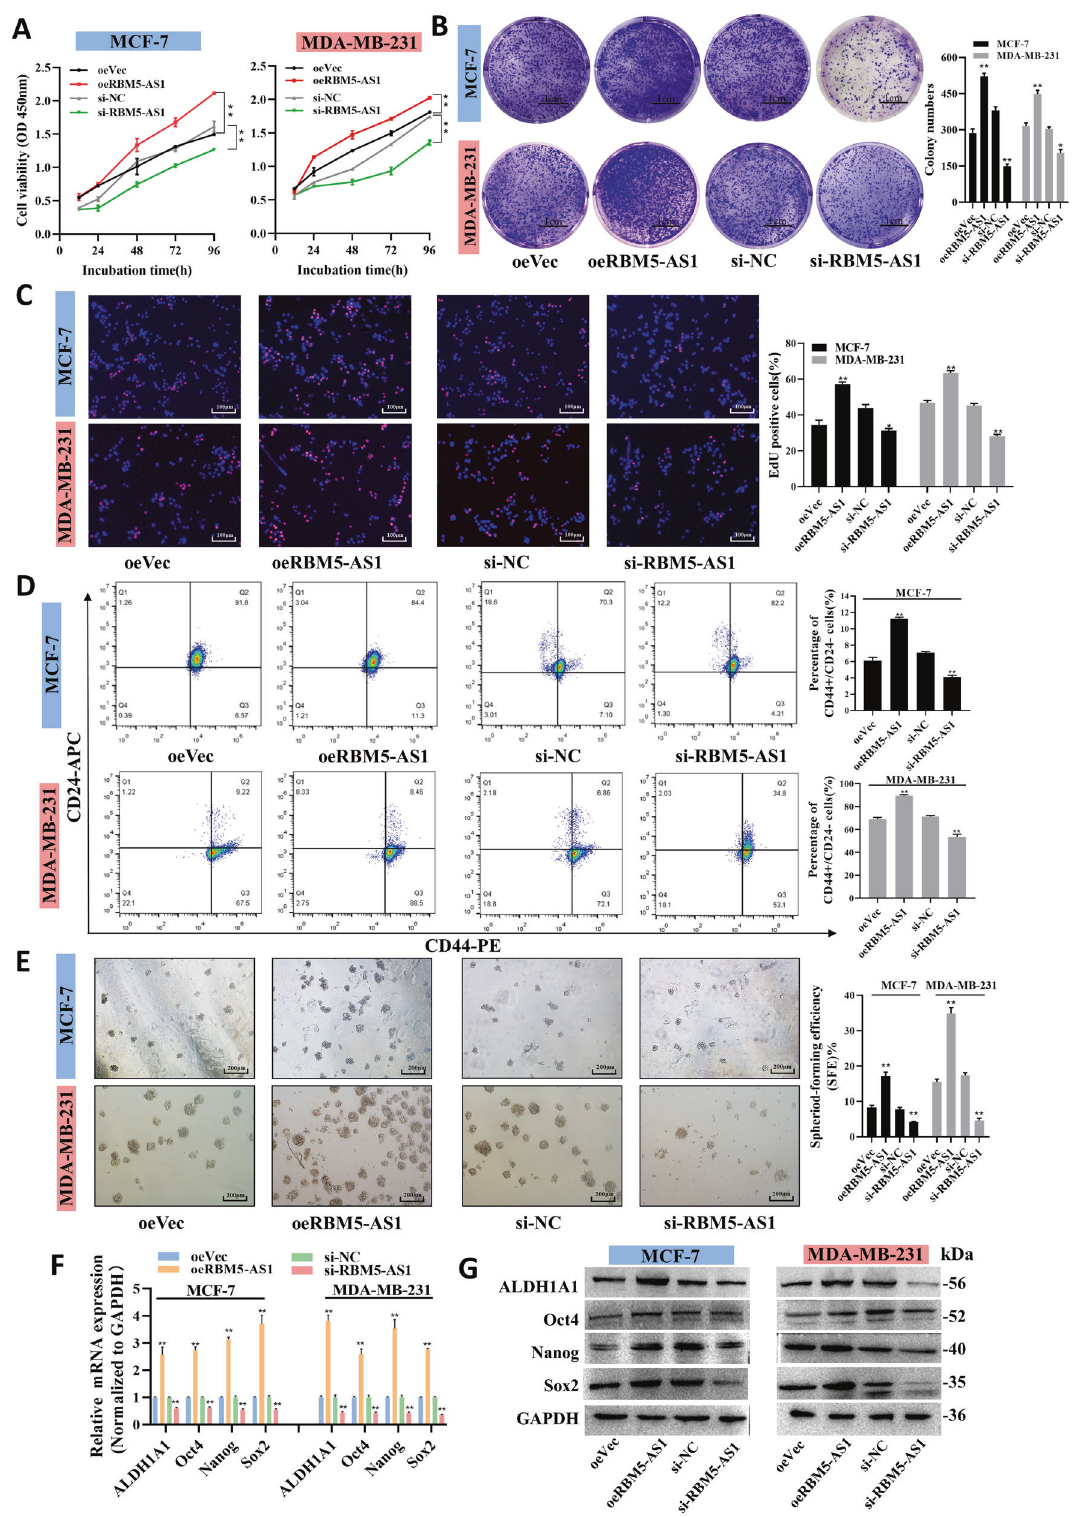
Fig. 3 RBM5-AS1 promotes proliferation and stemness of breast cancer cell in vitro. Proliferation capacity of MCF-7 and MDA-MB-231 cells with RBM5-AS1 overexpression or knockdown examined by CCK-8 assays (A), plate colony formation assays ( B , scale bar, 1 cm) and EdU assays ( C , scale bar, 100 μ m). D Proportion of CD44 + CD24 − cells in RBM5-AS1-overexpressing or RBM5-AS1-knocked down MCF-7 and MDA-MB-231 cells detected by fl ow cytometric analysis. E Sphere-formation abilities of MCF-7 and MDA-MB-231 cells with RBM5-AS1 overexpression or knockdown. SFEs are shown in the right panel. Scale bar, 200 μ m. mRNA ( F ) and protein levels ( G ) of pluripotent transcription factors in MCF-7 and MDA-MB-231 cells with RBM5-AS1 overexpression or knockdown. All data are shown as the mean ± SEM. * P < 0.05 and ** P < 0.01 by two- tailed Student ’ s t